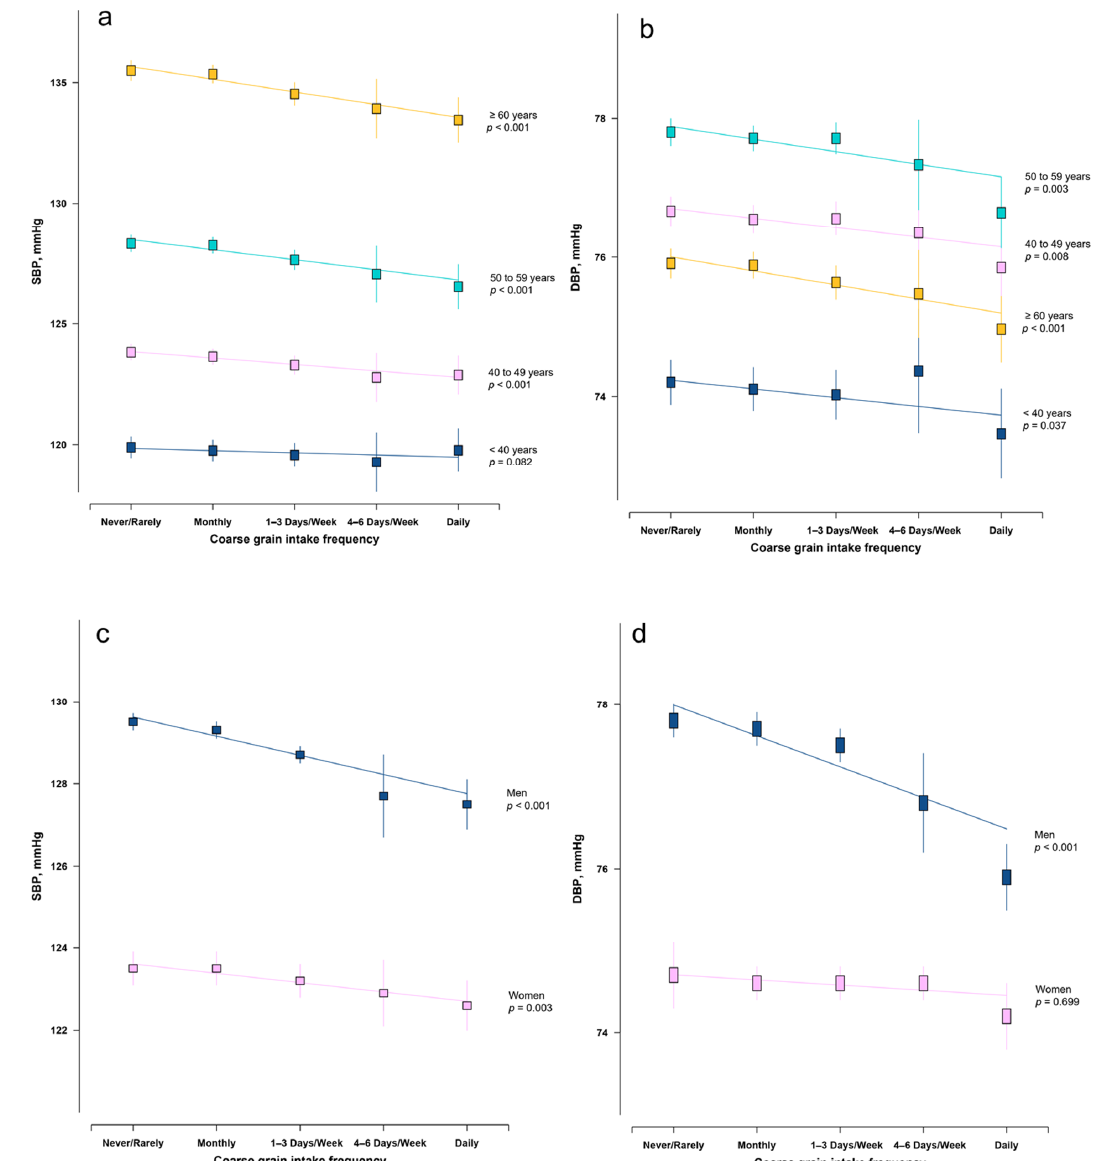
Figure 1. Adjusted systolic blood pressure (SBP) and diastolic blood pressure (DBP) by coarse grain intake frequency, age ( a , b ) and sex ( c , d ). Values were means adjusted for age, sex, study area, education level, smoking, alcohol drinking, physical activity level, body mass index (BMI), and local outdoor temperature.